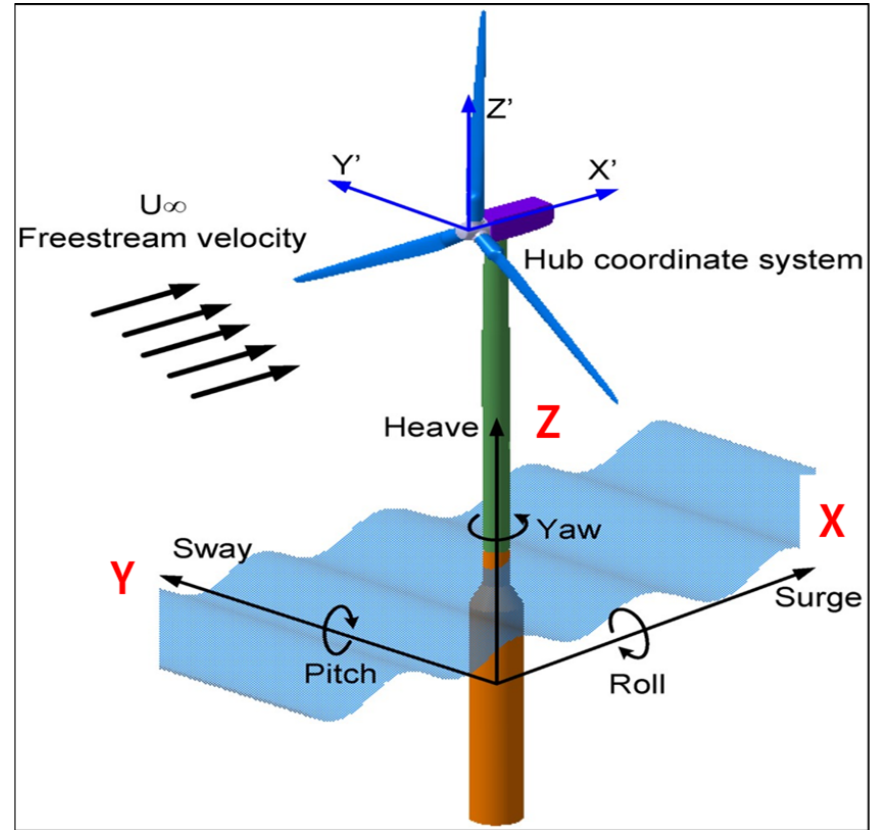
Figure 10. The degrees of freedom of a FOWT with a spar substructure [56].